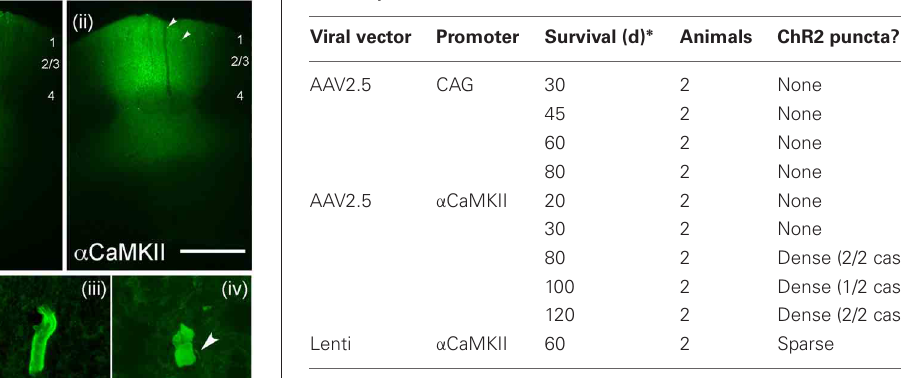
Table 1 | Axonal abnormalities after viral expression of